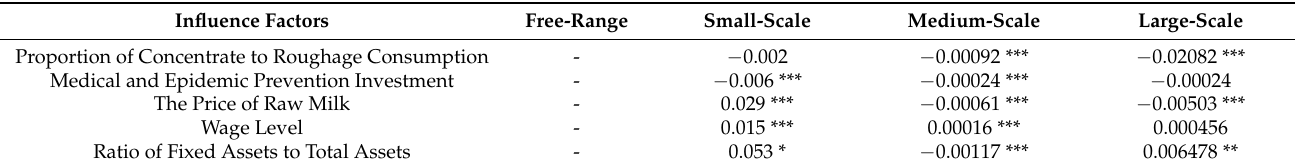
Table 8. Parameter estimation of Tobit